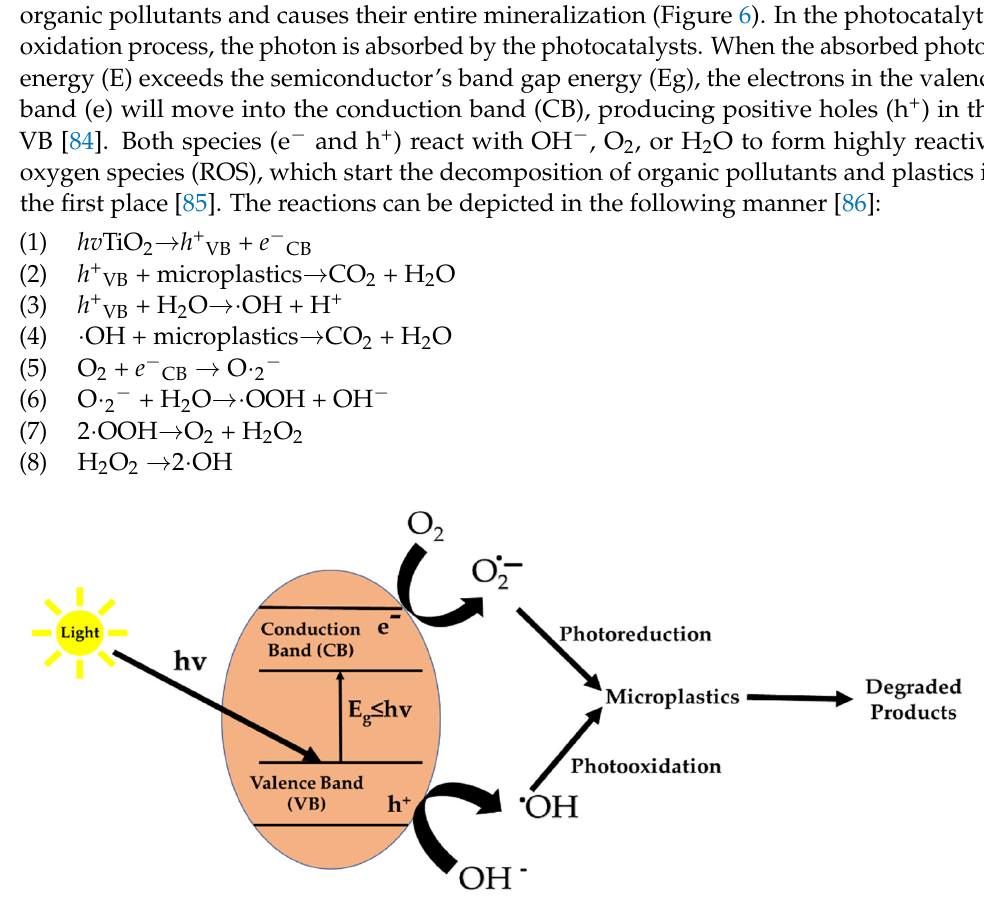
Figure 6. Mechanism for microplastic degradation using photocatalysis method [87].